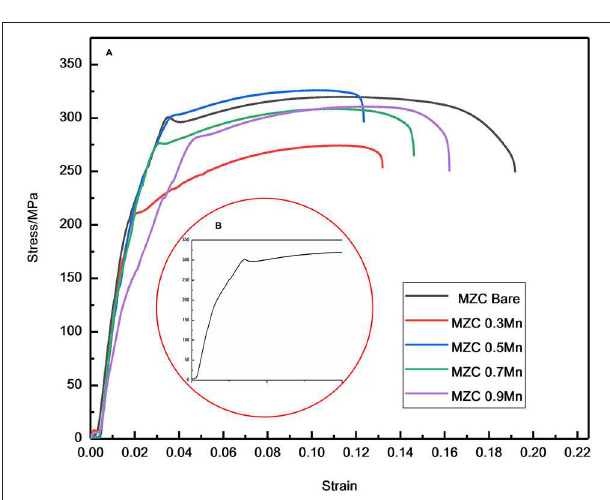
FIGURE 7 | The XRD patterns of as-extruded MZC (1), MZC0.3Mn (2), MZC0.5 Mn (3),MZC0.7Mn (4) and MZC0.9 Mn (5) alloys.